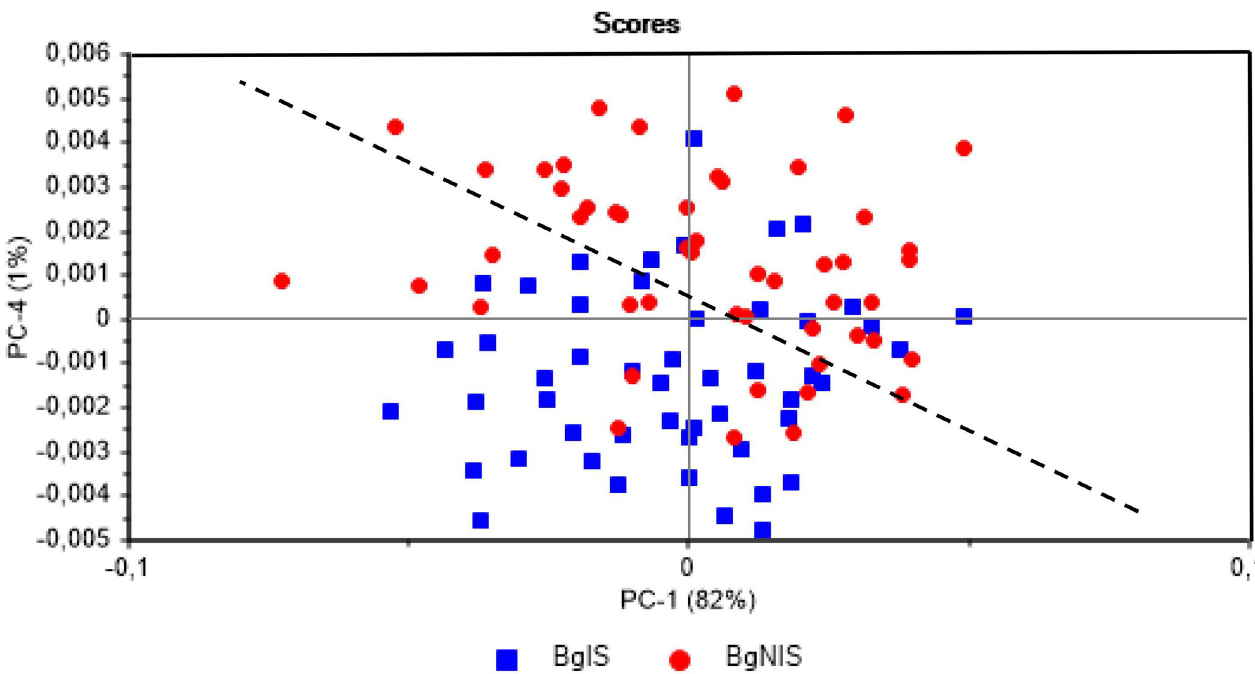
Fig 4. FT-NIR spectra of the parasitological diagnosis. Plot of the scores obtained by Principal Component analysis (PCA) of live Biomphalaria snails infected and unexposed to Schistosoma mansoni . BgIS = infected Biomphalaria glabrata ; BgNIS = Biomphalaria glabrata not exposed to infection.